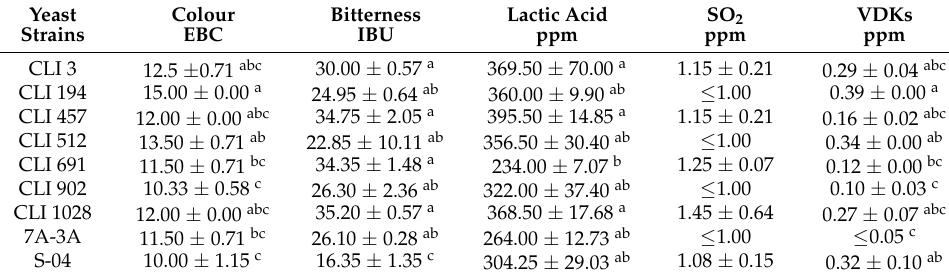
Table 4. Main parameters analysed with CDR of sequentially fermented beers after